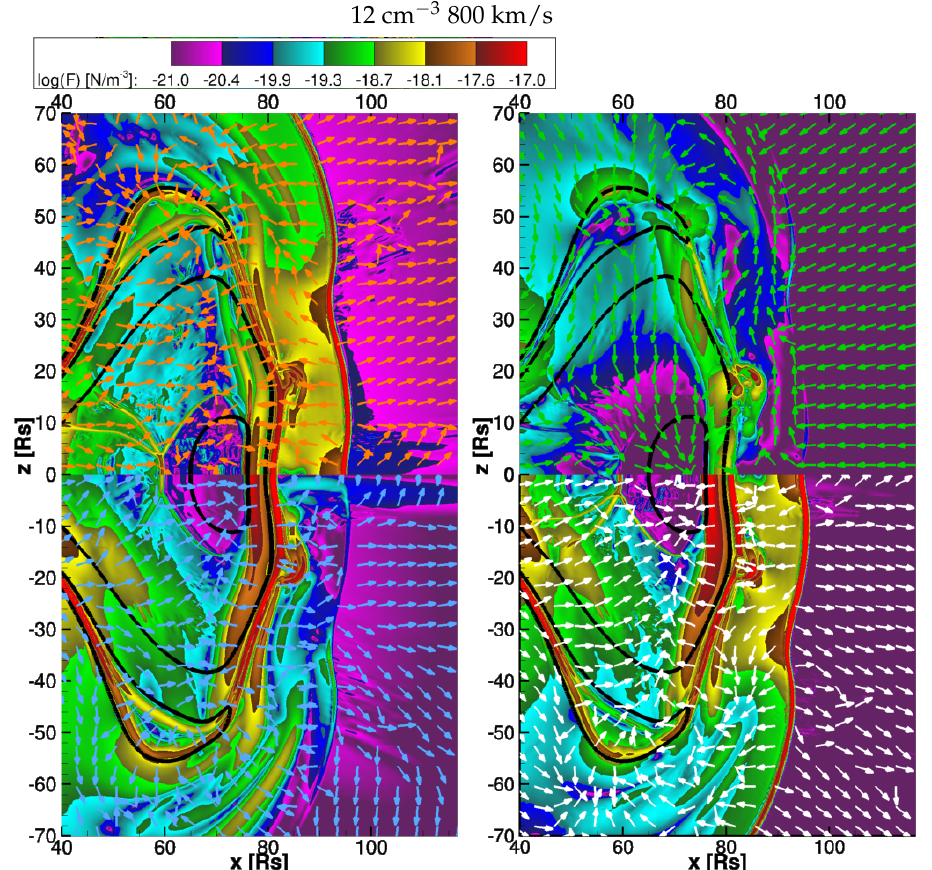
Figure 5. Forces that act upon a normal CME ejected in a high density background wind with a medium initial velocity 20 h after initiation. Colours contours represent the magnitude of the force and the vectors represent the direction of the force. Upper left: Plasma pressure gradient. Upper right: Magnetic tension. Lower left: Magnetic pressure gradient. Lower right: Total